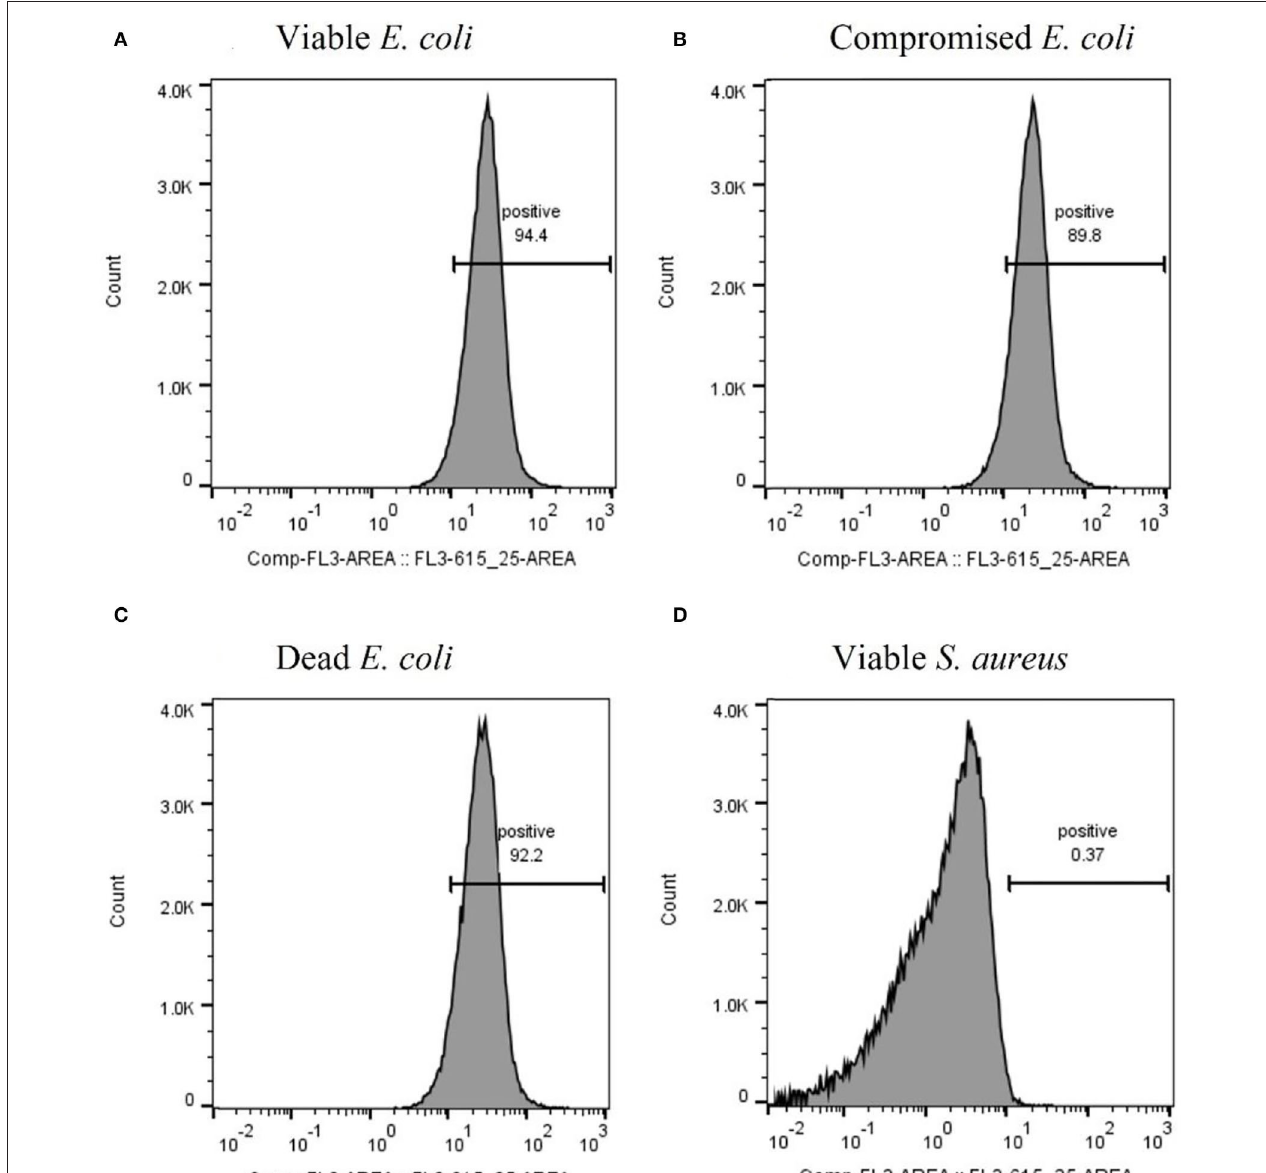
FIGURE 3 | Assessment of the binding ability of mCherry-Gp17 to cells in different viability states by flow cytometry. Representative histograms were obtained from the analysis of viable (A) , compromised (B) , and dead (C) E. coli HB104 cells and viable S. aureus HB22 (D) (negative control) after incubation with mCherry-Gp17.